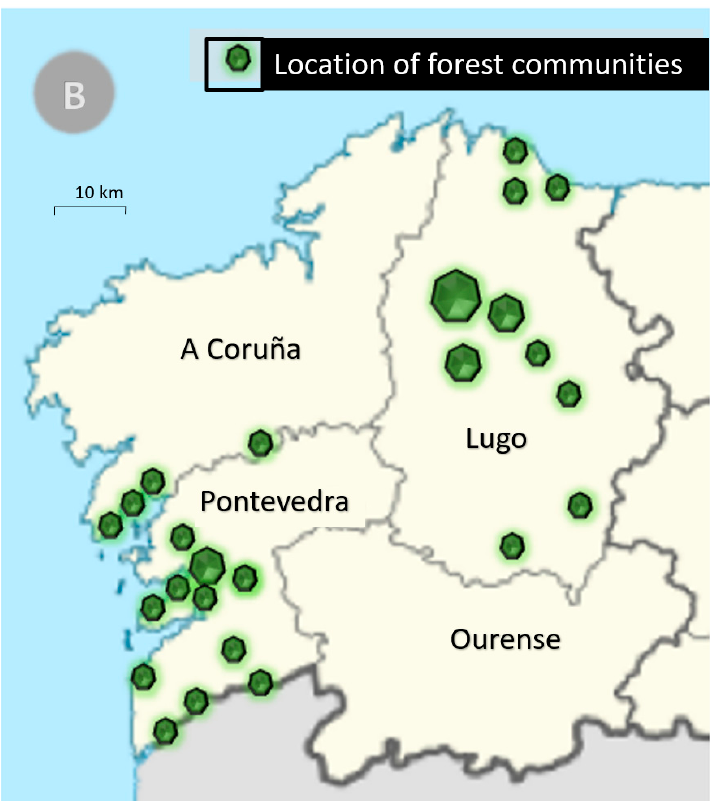
Figure 3. ( A ) Location of forest communities participating in the bioenergy project; ( B ) forest communities with no energy use of their resources.